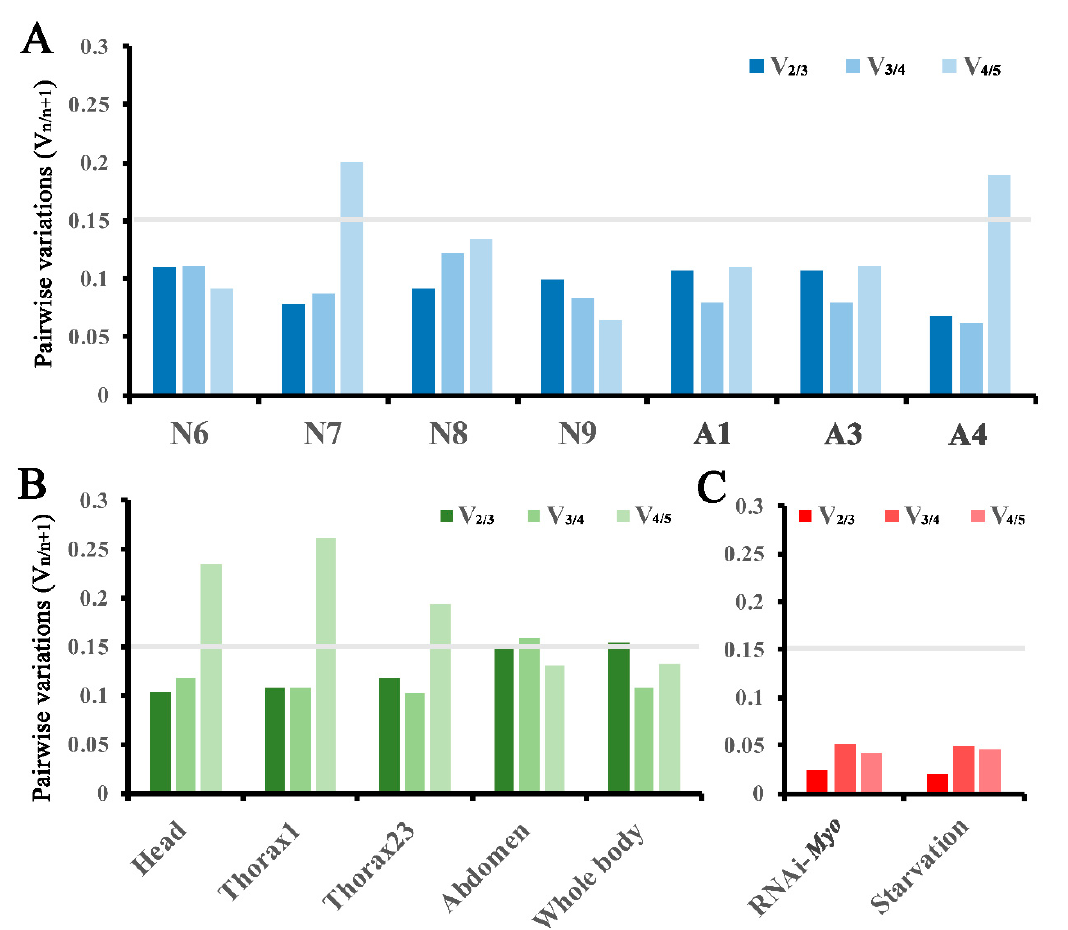
Figure 5. Evaluation of the optimal number of reference genes for normalization in Thermobia domestica. The pairwise variations (V n/n+1 , n is the number of reference genes) was calculated between two sequential normalization factors (NF n and NF n+1 ) by geNorm with a cut-off value of 0.15 [12] using data: ( A ) from different tissues at the developmental stages of N6–N9, A1, A3, and A4; ( B ) at different developmental stages in the head, prothorax, mesothorax/metathorax, and abdomen; ( C ) in whole insects at the 8th nymphal instar under RNAi and starvation treatments.